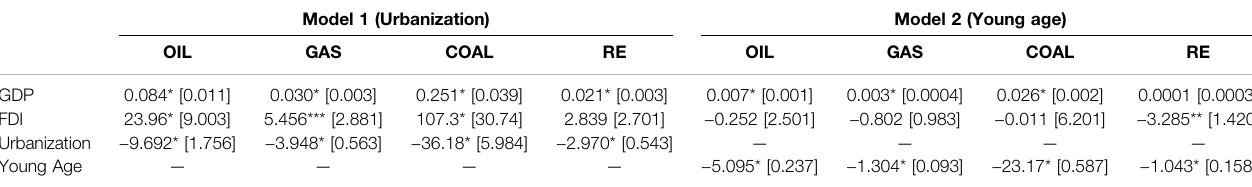
TABLE 5 | Hainmueller and Hazlett (2014) Kernel-based regularized least squares.